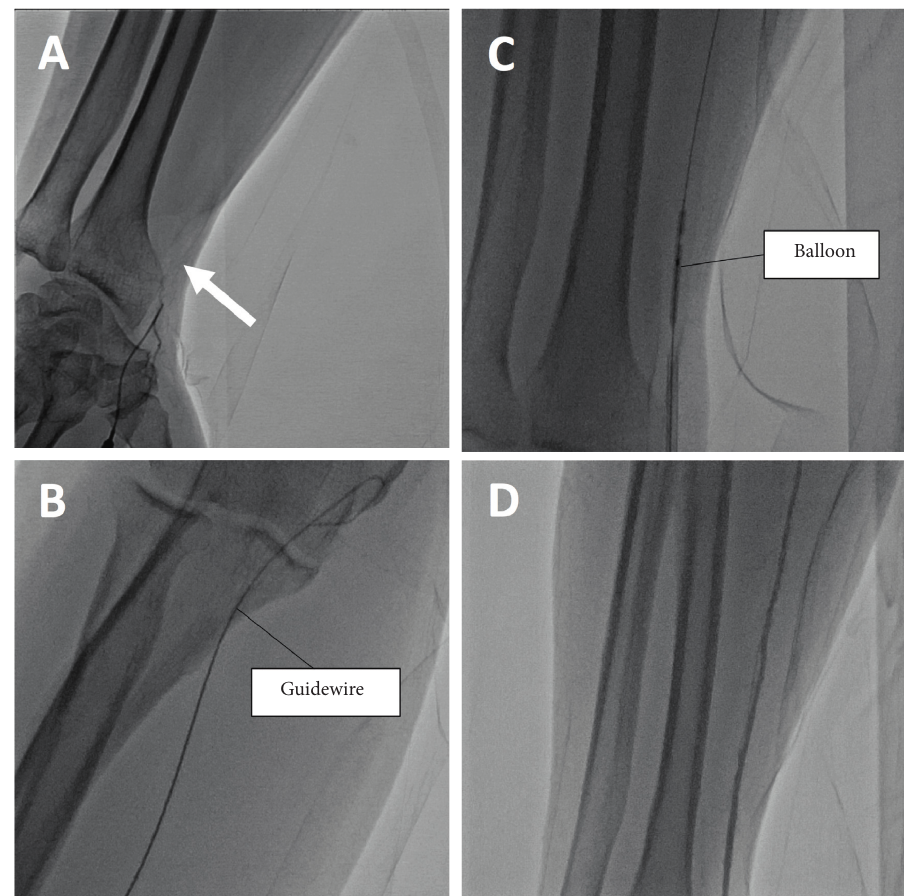
Figure 6: (a) Angiography from the distal radial artery shows the total occlusion of the radial artery (arrow). (b) Guidewire advance into the brachial artery. (c) After an exchange to 0.014-inch guidewire, balloon dilatation is performed. (d) Angiography from the distal radial artery shows the patency of the radial artery after the